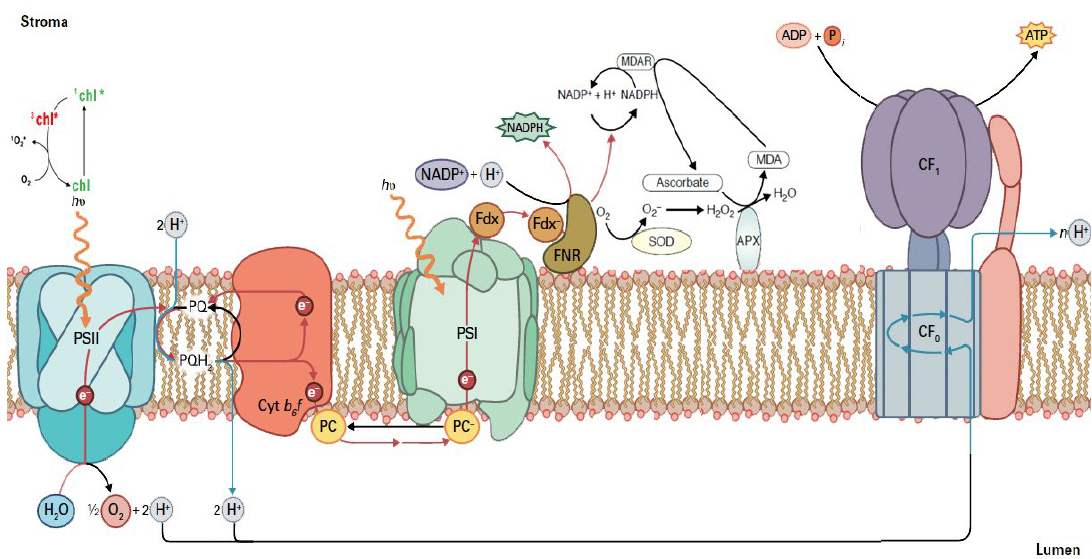
Figure 1. Light energy capture and utilization in the thylakoids of chloroplasts. The electron transport chain from photosystem II (PSII) to photosystem I (PSI) and finally to ferredoxin (Fdx) to form NADPH, is depicted. Detail explanation in the text (Adopted from [26]).